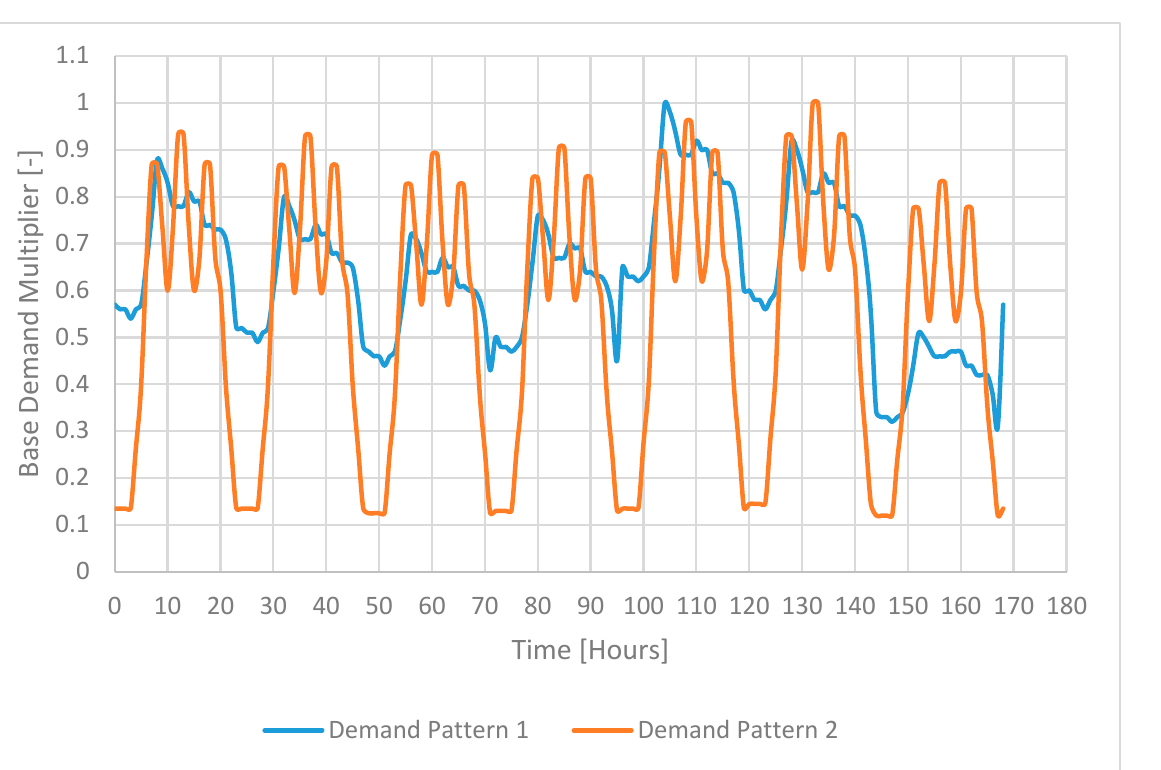
Figure 2. The demand patterns used for both example applications .